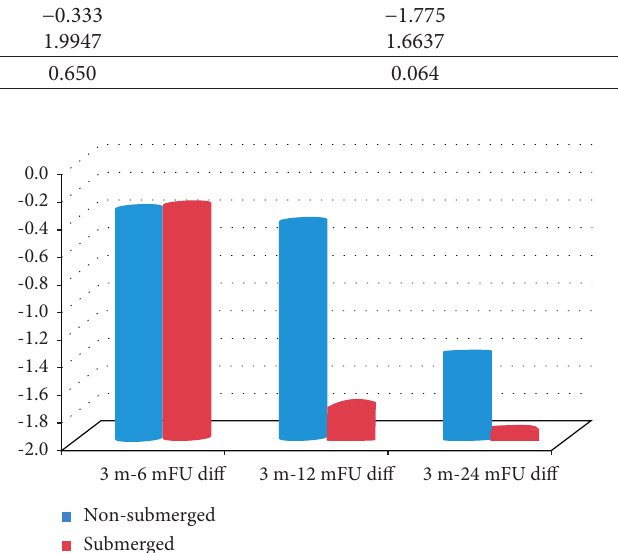
Figure 6: Mean PTV difference between NS and S in the ball attachment